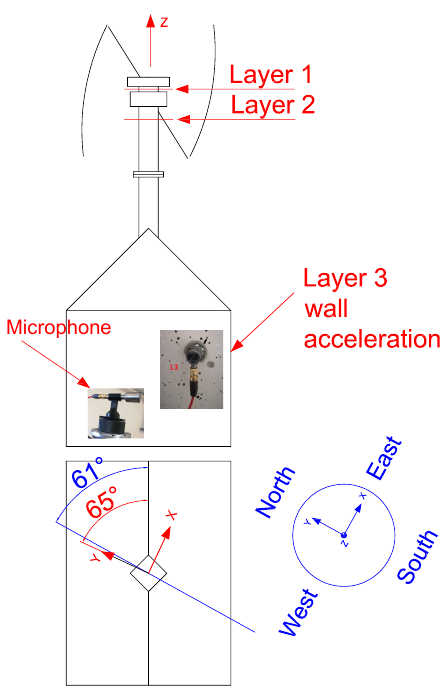
Figure 7. Scheme of accelerometers and microphone arrangements (not to